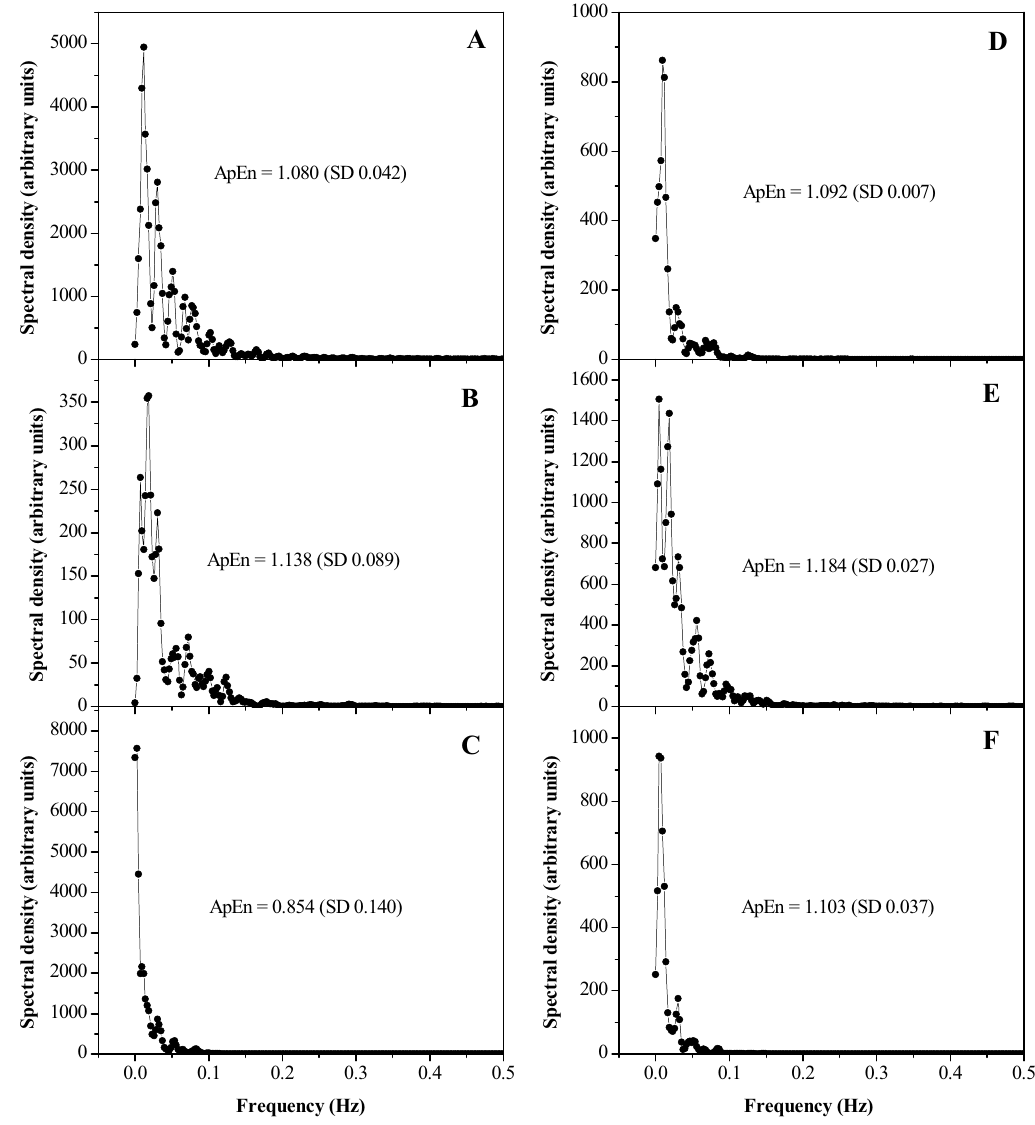
Fig. 2 – Spectral analysis by FFT of sap flow time series of G. ulmifolia (A, B, C) and C. legalis (D, E, F) at control (A, D), water deficit (B, E), and recovery (C, F) conditions. Mean values of Approximate Entropy (ApEn) are shown inside each figure (n = 3, SD = standard